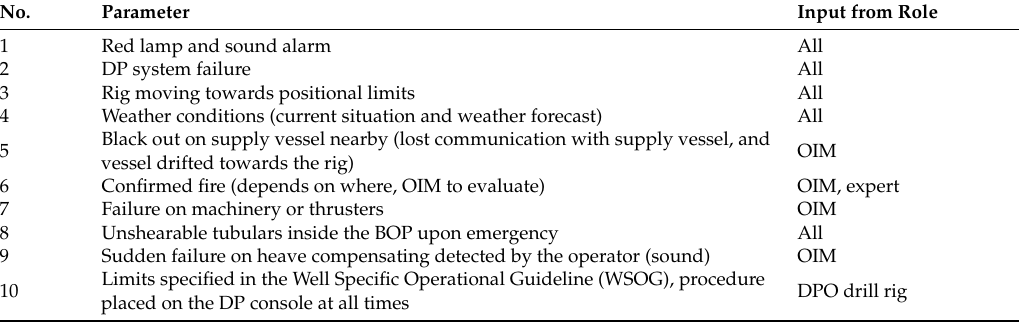
Table 5. Interview findings of information parameters used for assessing need for